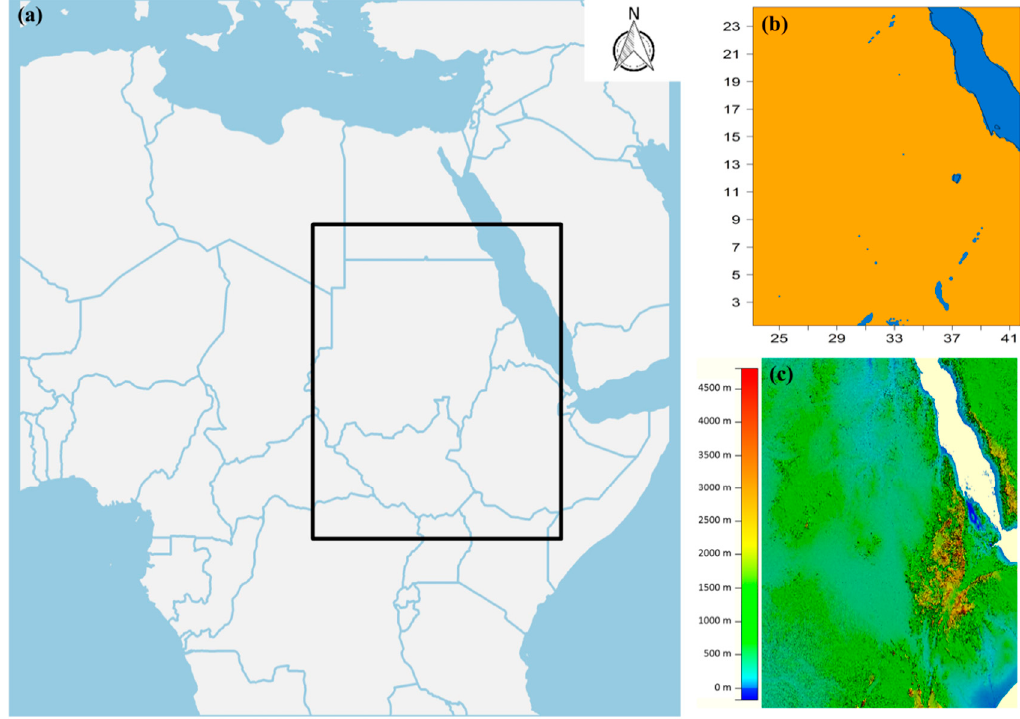
Figure 1. ( a ) Nested domain extent of the Eastern Nile Basin (ENB), ( b ) land mask for the ENB domain, longitude on the horizontal axis and Latitude on the vertical axis, and ( c ) topography of the study area.